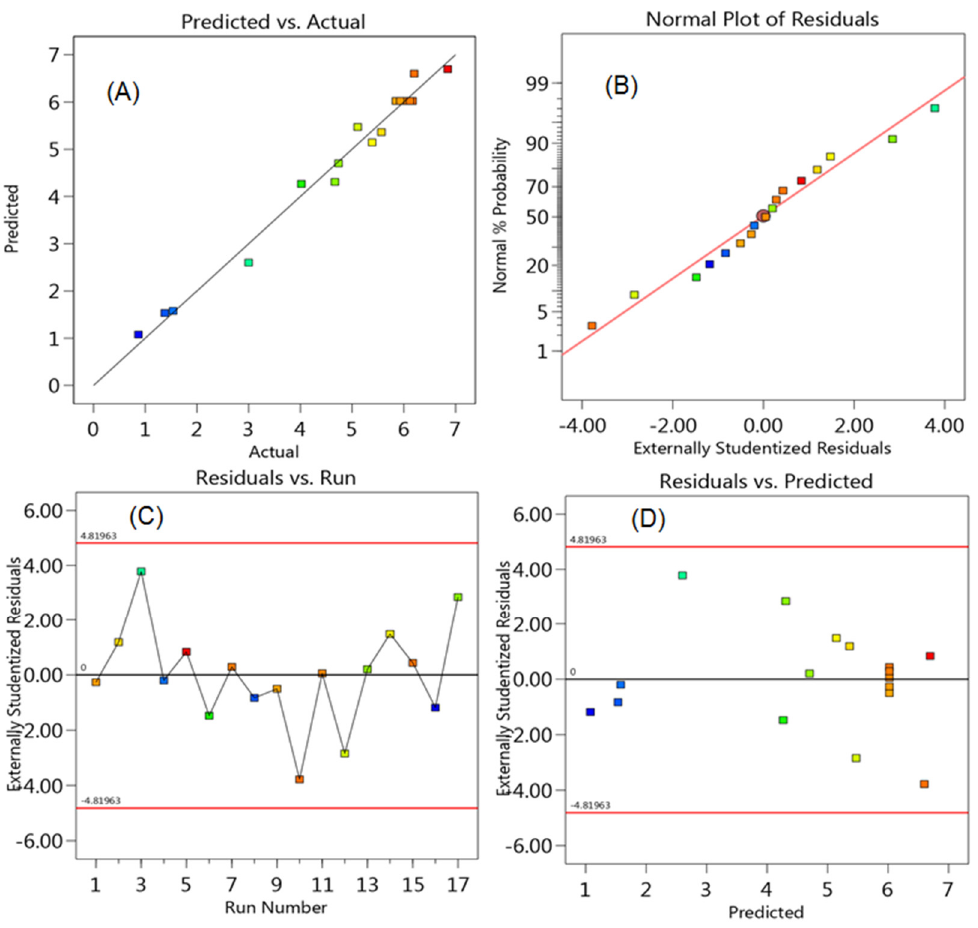
Figure 4. Diagnostic plots for resolution of RGE to IS showing the predicted vs. actual ( A ) normal plot of residuals ( B ), residuals against run ( C ) and predicted values ( D ).